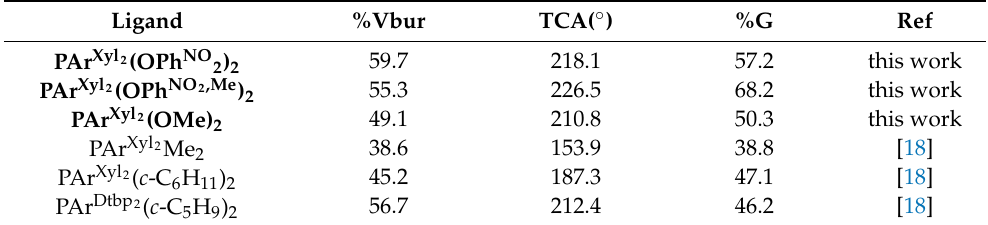
Table 1. %V bur , TCA y %G values for the phosphonites studied in this work and for some related phosphine